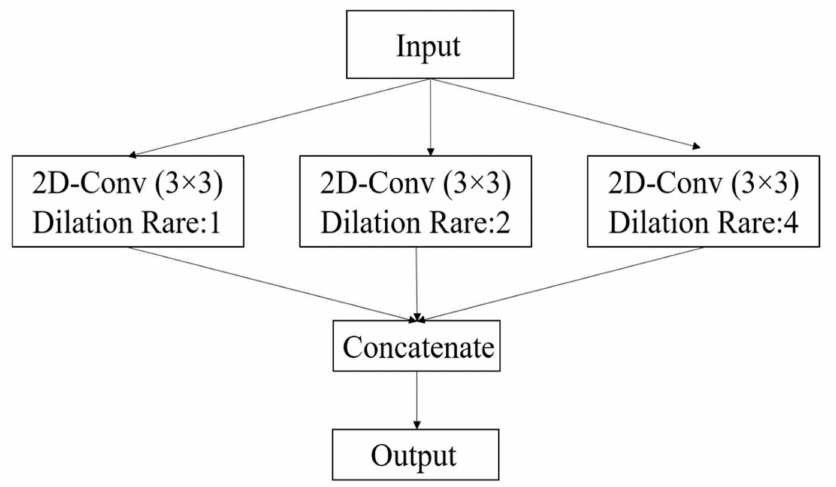
Figure 2. General workflow of building extraction displaying various kernels of 2D-convolution when applying CNN-related